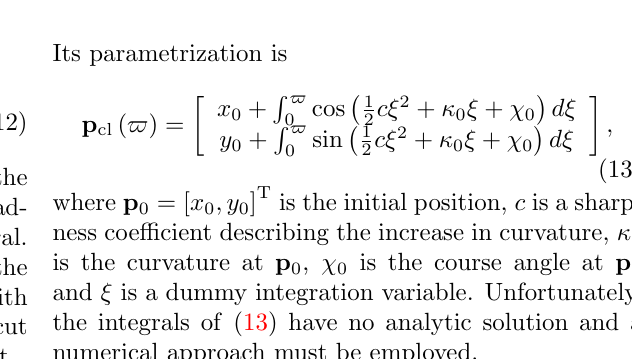
Figure 4: Circular smoothing path geometric proper- ties